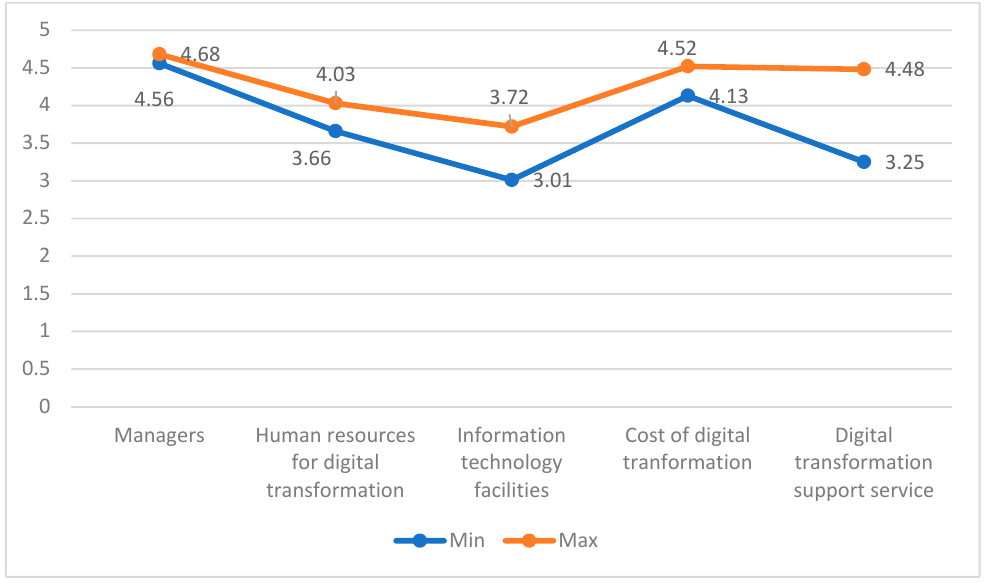
Figure 11. The average maximum and minimum values of factors affecting digital transformation activities of logistics enterprises.